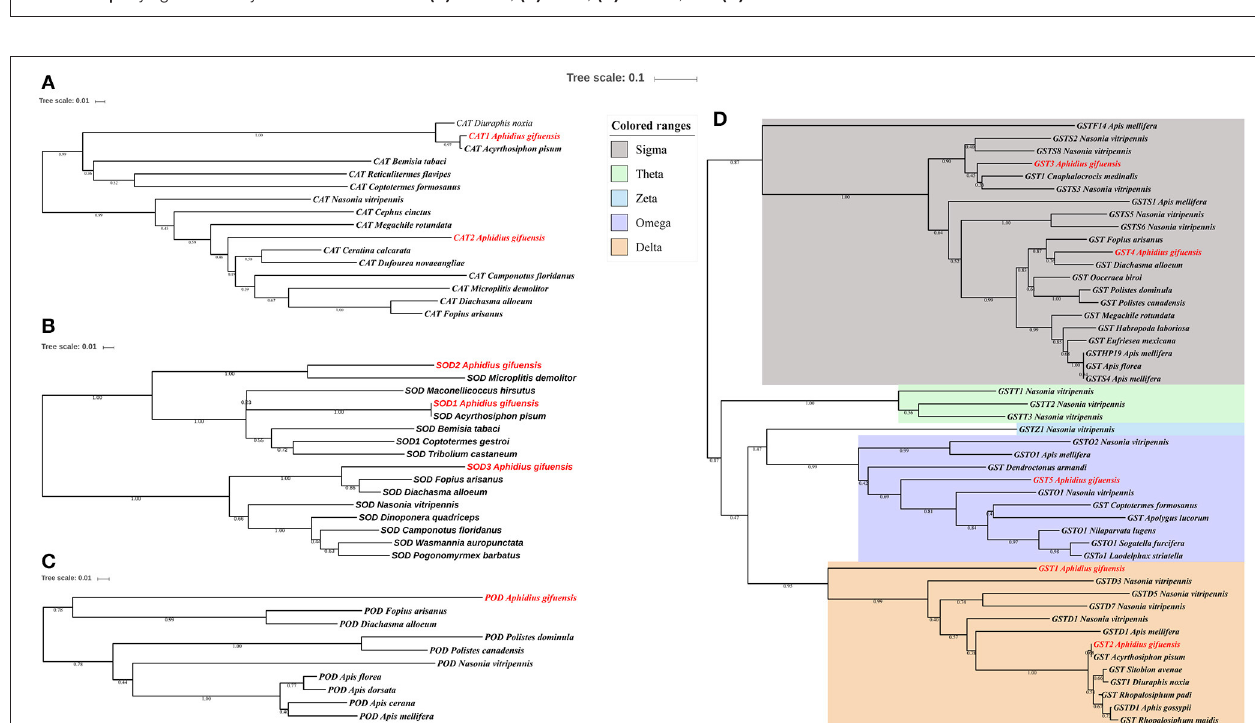
FIGURE 2 | Phylogenetic analysis of antioxidant enzyme genes in insects. (A) Superoxide dismutase (SOD), (B) peroxidases (POD), (C) catalase (CAT), (D) glutathione-S-transferases (GST).